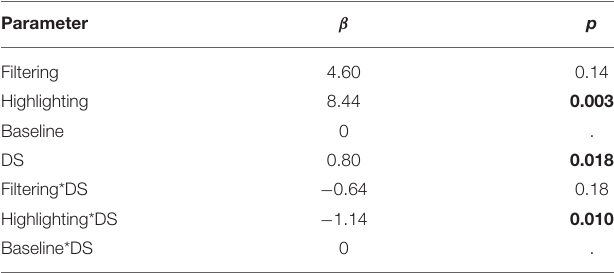
TABLE 6 | Experiment 2, Effect sizes for main effects of condition, digit span (DS), and the interaction between them. Parameter β p Filtering 4.60 0.14 Highlighting 8.44 0.003 Baseline